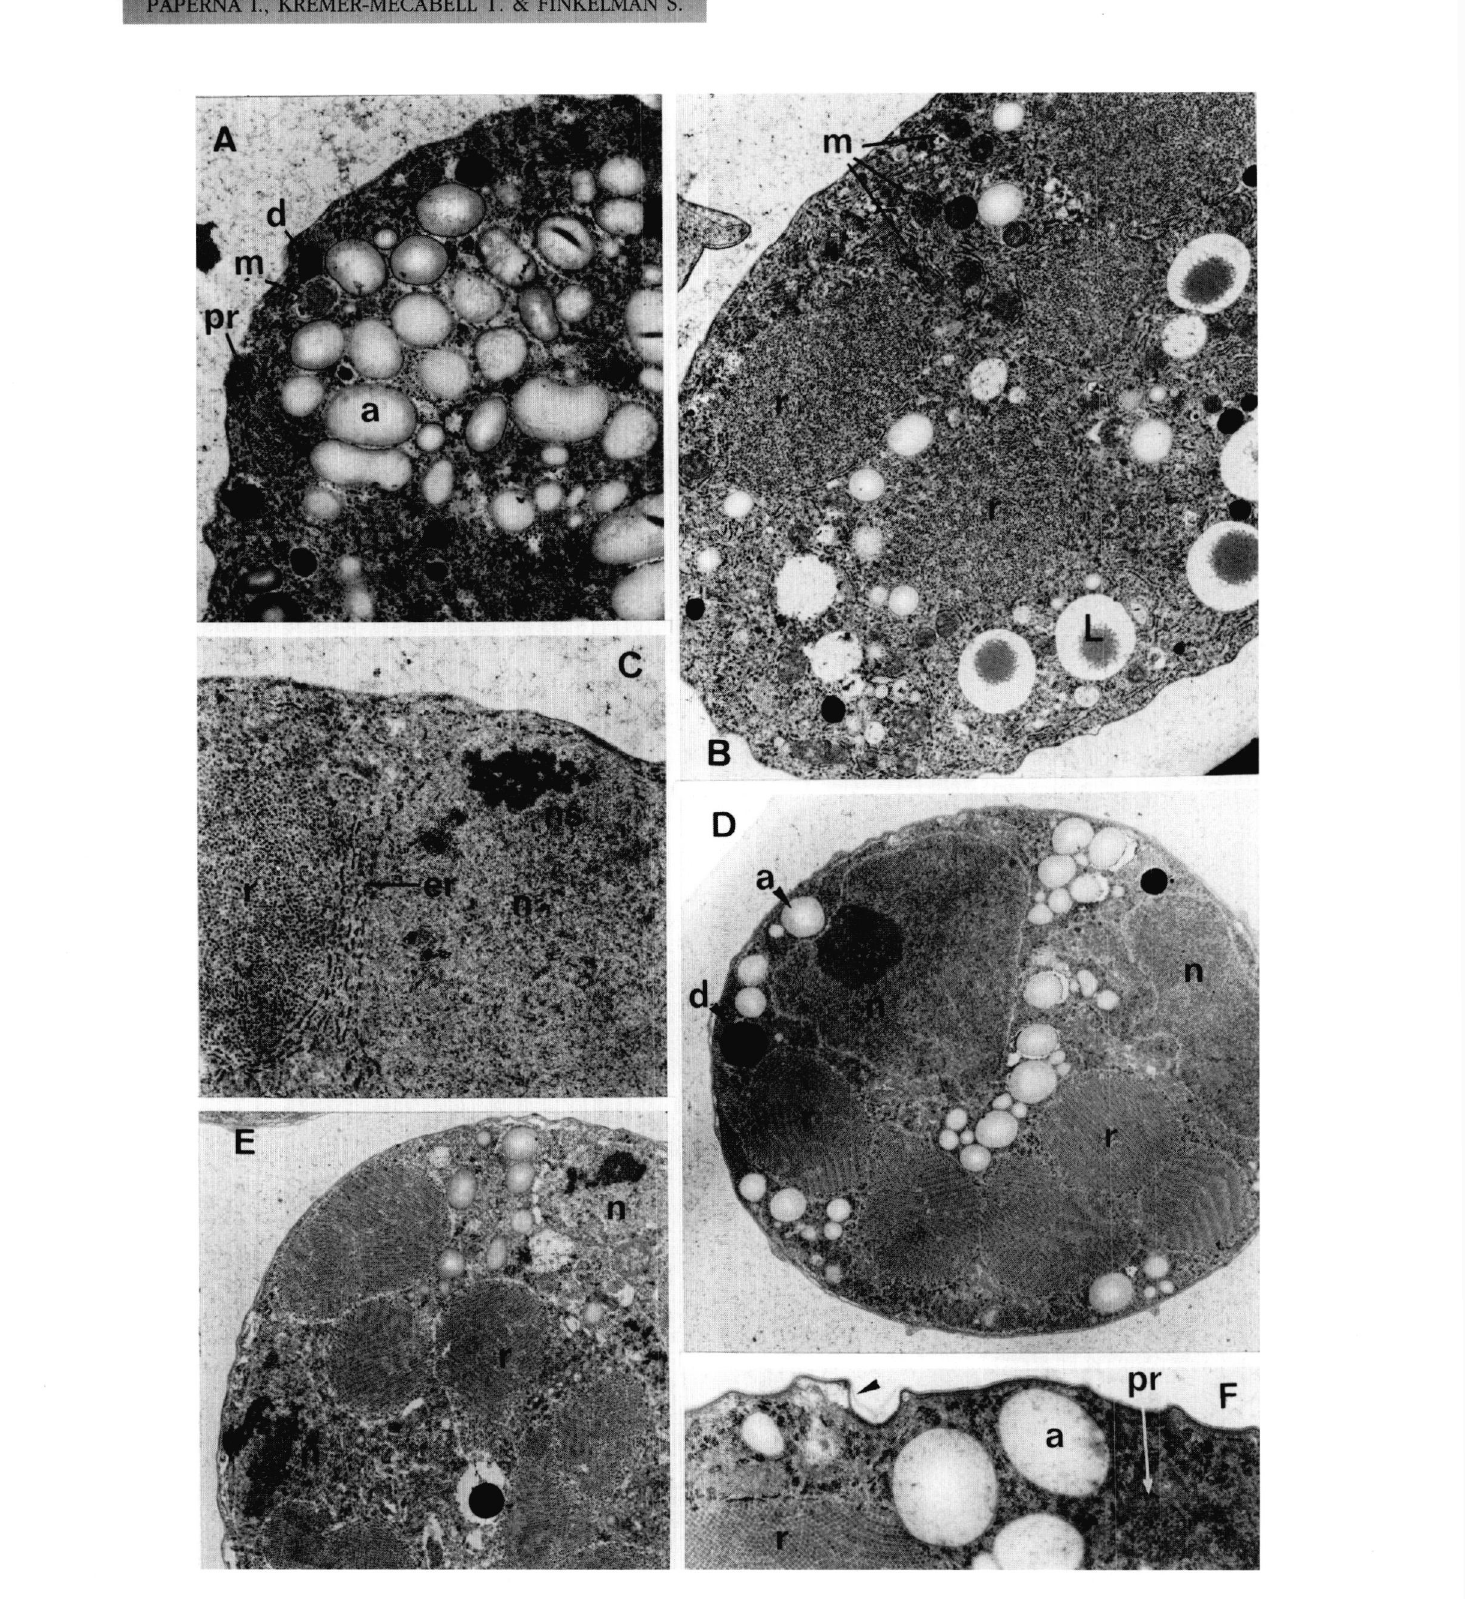
Fig. 4. - Electron microscopic images of sporocysts from infected ticks. A. Newly formed sporocyst filled with amylopectin granules, sho­ wing anlagen of crystalloid bodies enclosed in rough ER (pr) mitochondria (m) and electron-dense bodies (d); x 7,150. B. Sporocyst with ER-aligned inclusion of pre-crystalloid granular bodies (r), showing also mitochondria (m) and lipid vacuoles (L); x 6,400. C. Sector of divided sporocysts showing a nucleus (n) with scattered nucleolus (ns), and ER (er) aligning the pre-crystalloid granular body (r): x 10,344. D,E. Sporocysts with several nuclei (n), arrayed crystalloid bodies (r), amylopectin granules (a) and electron-dense bodies (d); x 6000 and X 6, 460. F. Walling process of a sporocyst, the forming wall is invested by a veil (arrowhead); In addition to the formed crystalloid body (r) a crystalloid anlage (pr) enclosed in ER still occurs; a, amylopectin granules; x